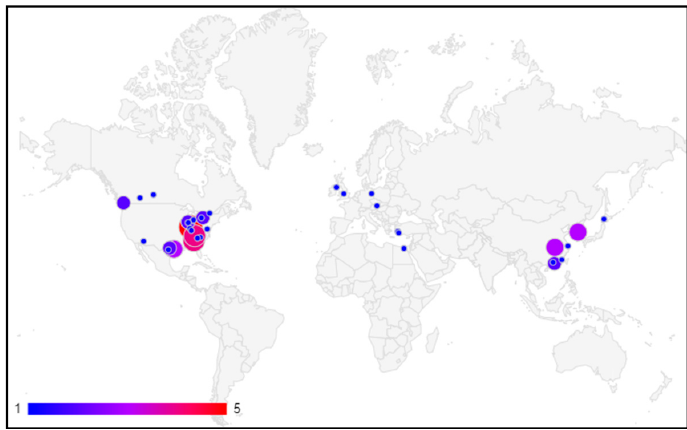
Figure 2. Location of greenway study sites by city.